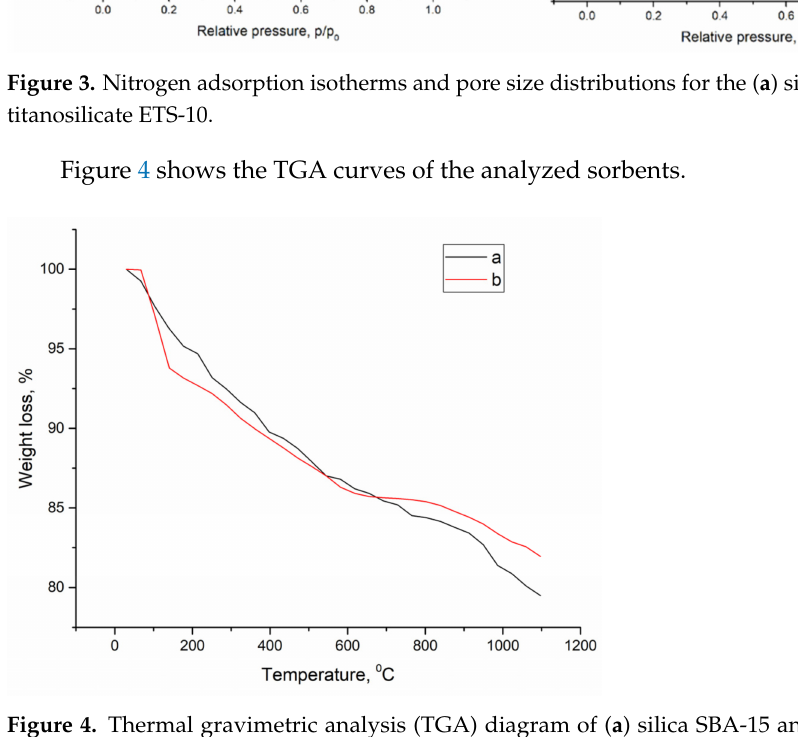
Figure 4. Thermal gravimetric analysis (TGA) diagram of ( a ) silica SBA-15 and ( b ) titanosilicate